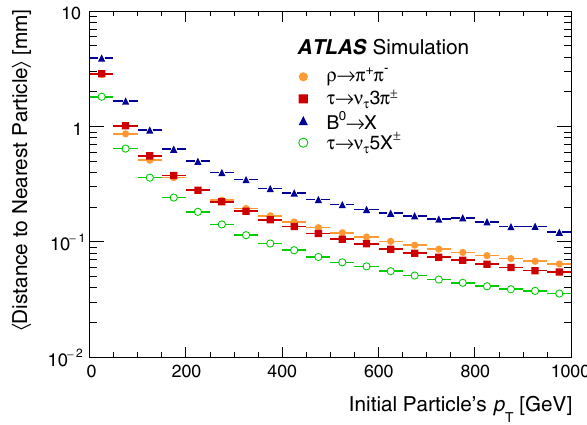
Fig. 8 A comparison of the average minimum distance between charged decay products at the IBL sensor surfaces as a function of initial particle’s p T for single-particle samples